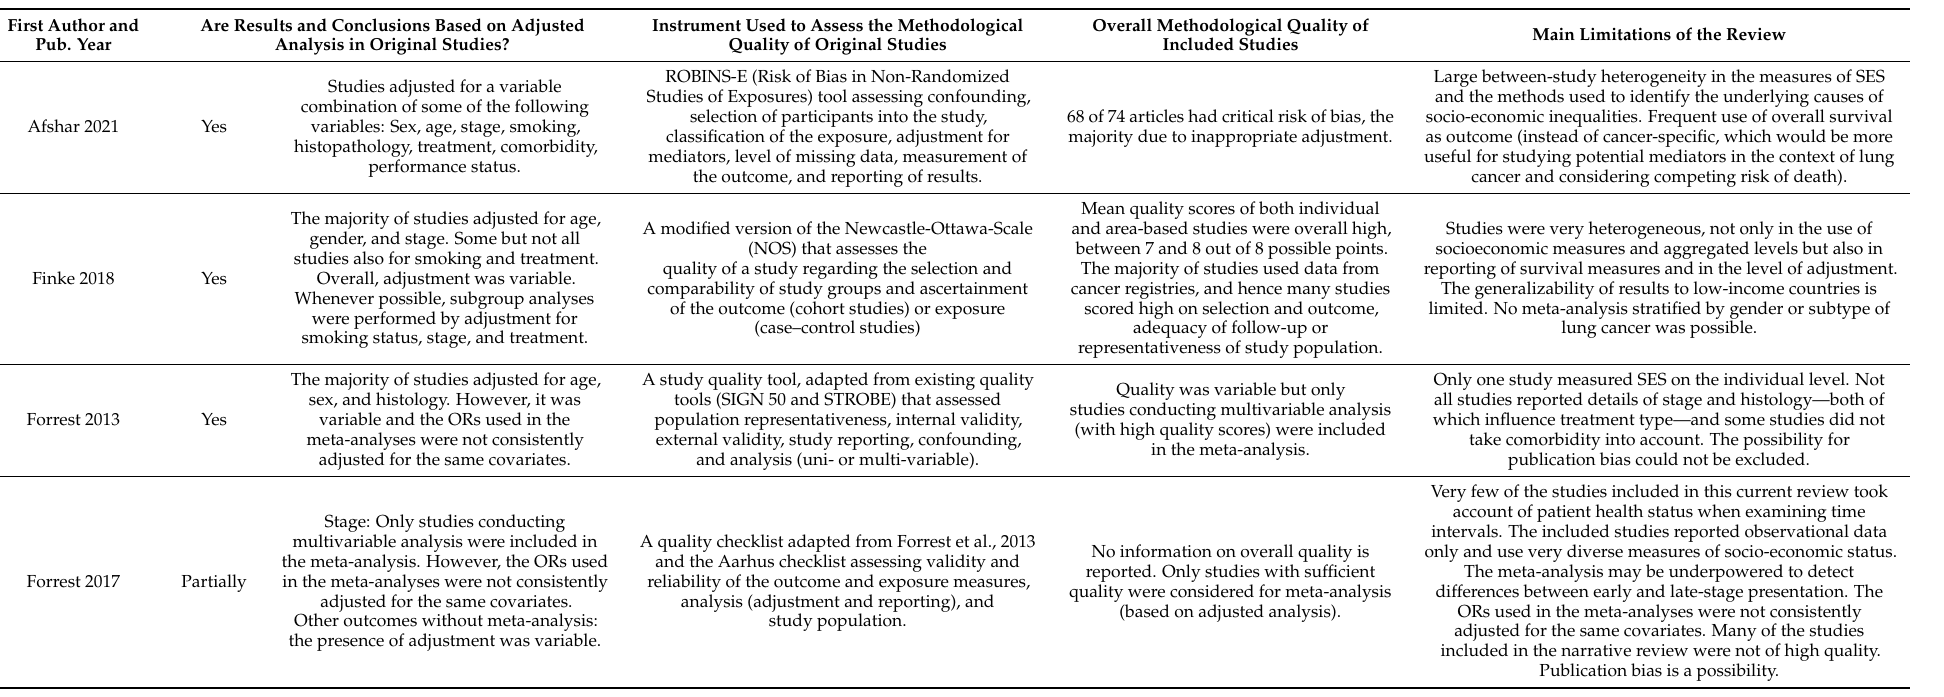
Table 2. Information about covariate adjustment, risk of bias assessment, and methodological limitations of each